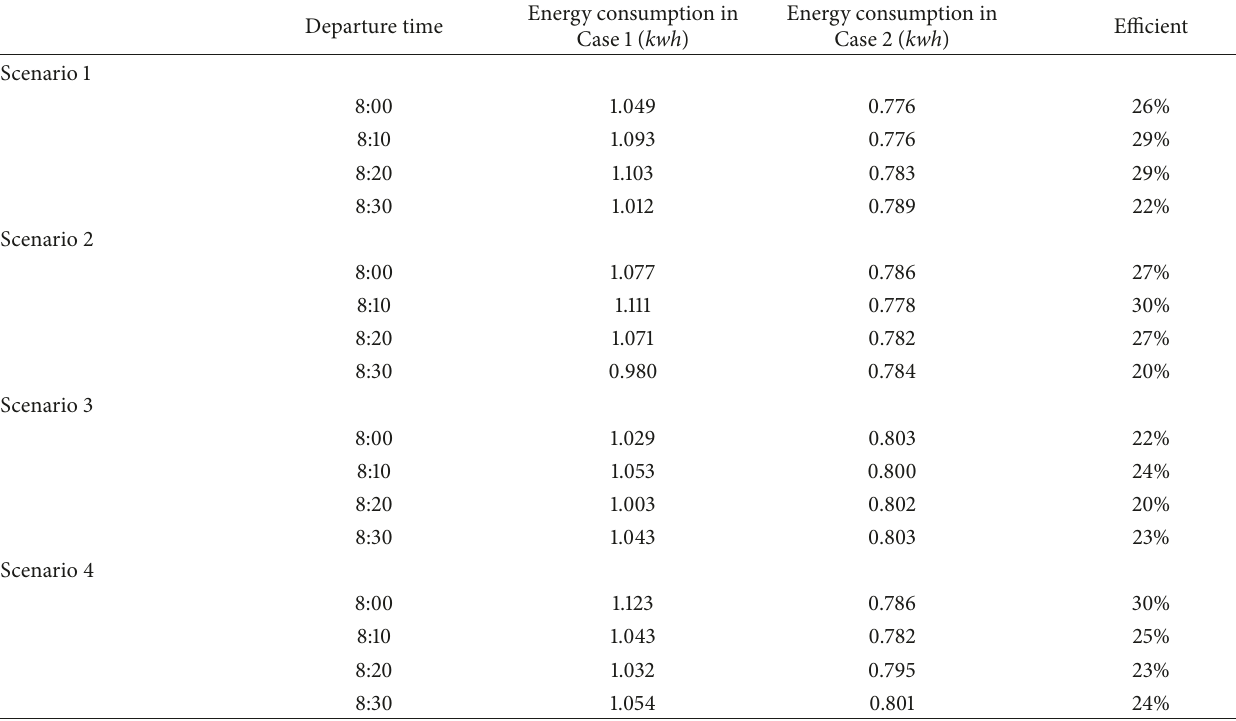
Table 11: The comparison of energy consumption in two cases under different signal timing and departure